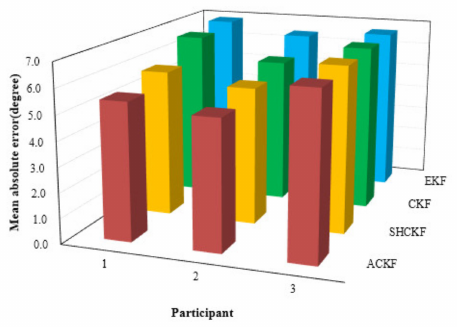
Figure 9. Distributions of the MAE of EKF, CKF, SHCKF, and ACKF results with respect to three